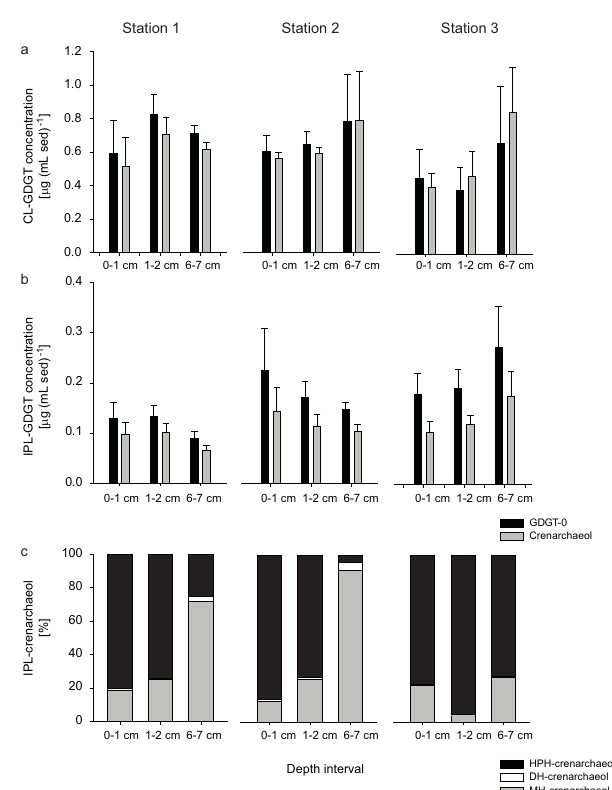
Fig. 5. GDGT-0 and crenarchaeol concentrations (averages), for CL-GDGTs (a) and IPL-derived GDGTs (b) at all three stations and core depths. Proportions of head groups of IPL-crenarchaeol at all three stations (c) .